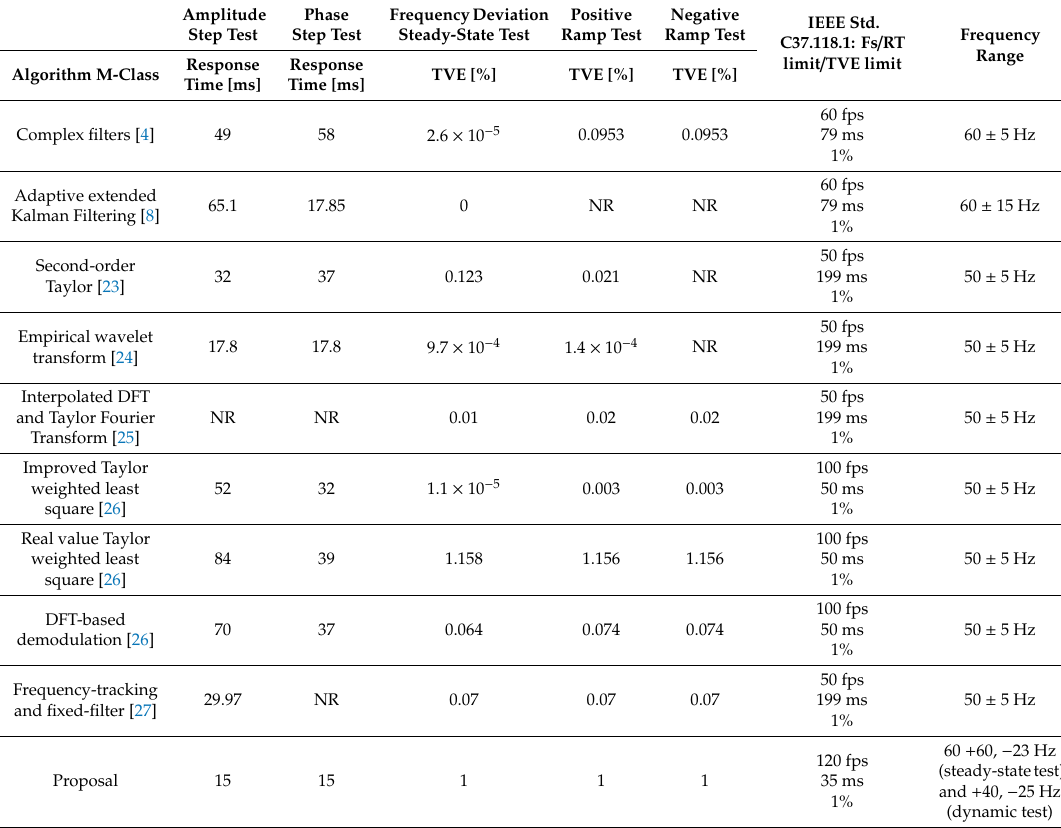
Table 5. M-class algorithm